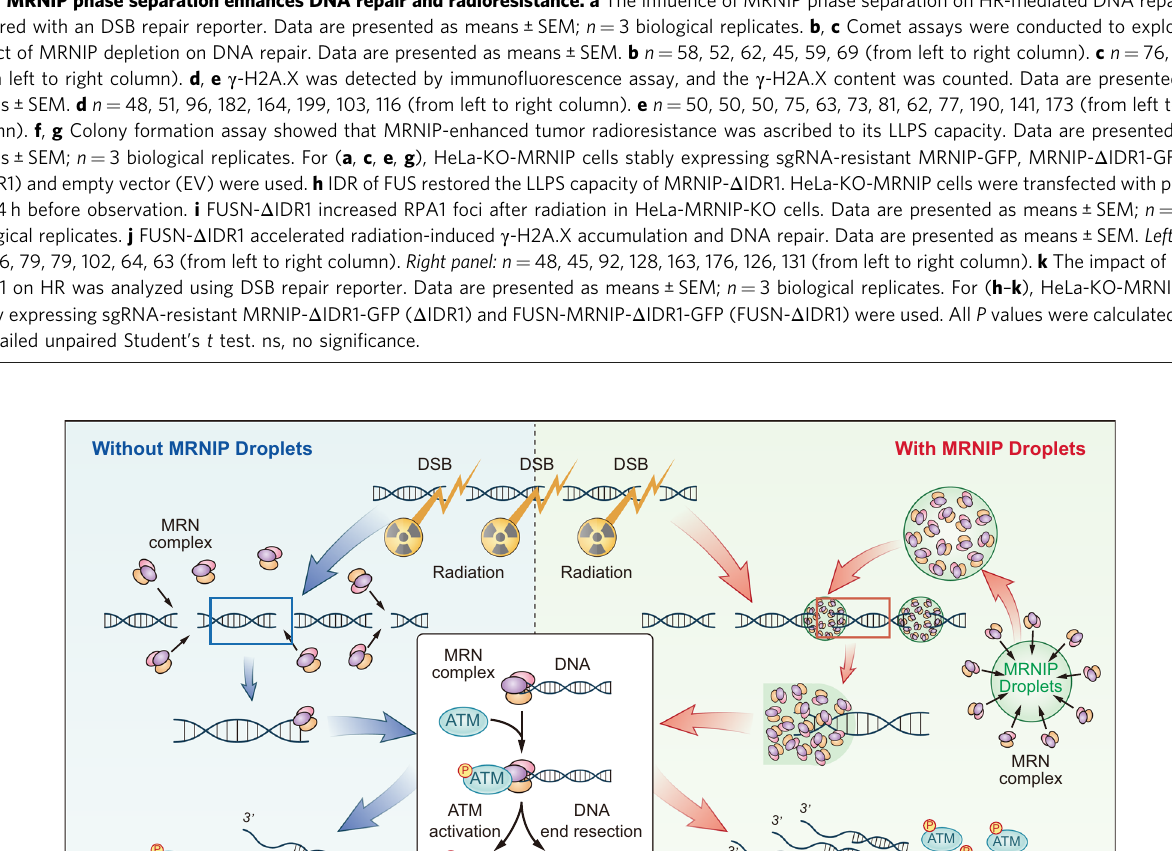
Fig. 7 MRNIP phase separation enhances DNA repair and radioresistance. a The in fl uence of MRNIP phase separation on HR-mediated DNA repair was explored with an DSB repair reporter. Data are presented as means ± SEM; n = 3 biological replicates. b , c Comet assays were conducted to explore the